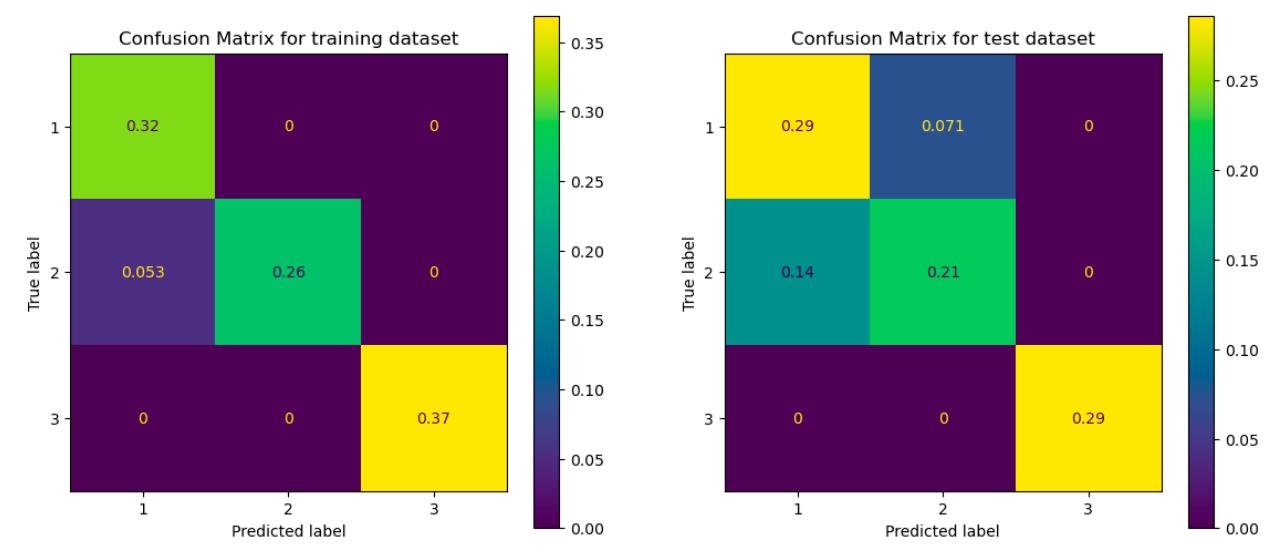
Figure 5. Confusion matrix of the training and test groups, regarding the samples’ membership to one of three portions.